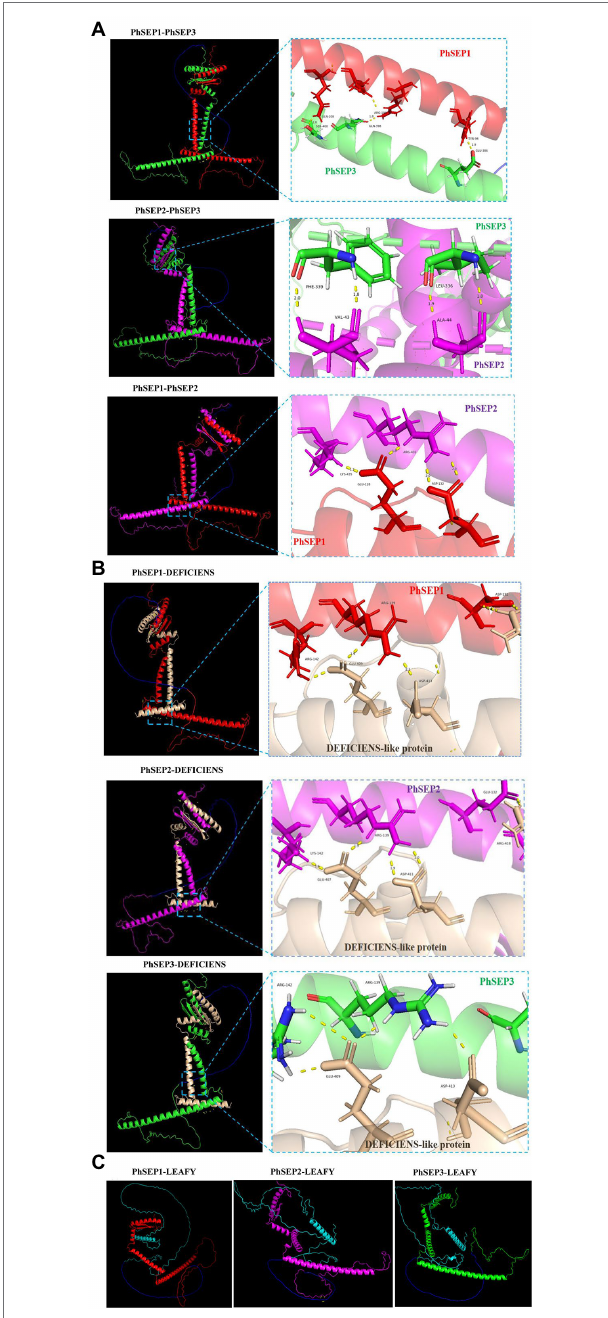
FIGURE 7 | The prediction of protein–protein interactions by DeepMind’s AlphaFold2 program. (A) The prediction of PhSEPs-PhSEPs interactions. (B) The prediction of PhSEPs-DEFICIENS interactions. (C) The prediction of PhSEPs-LEAFY interactions. The red chain represents the structure of the PhSEP1 protein. The magenta chain represents the structure of the PhSEP2 protein. The green chain represents the structure of the PhSEP3 protein. The wheat chain represents the structure of the DEFICIENS-like protein. The cyan chain represents the structure of the LEAFY protein. The blue chain represents the linker. The yellow stick represents the hydrogen bonds between any of the two proteins. In (A,B) each horizontal panel, the left image represents the predicted structure of the protein complex, and the right image represents the predicted protein interaction